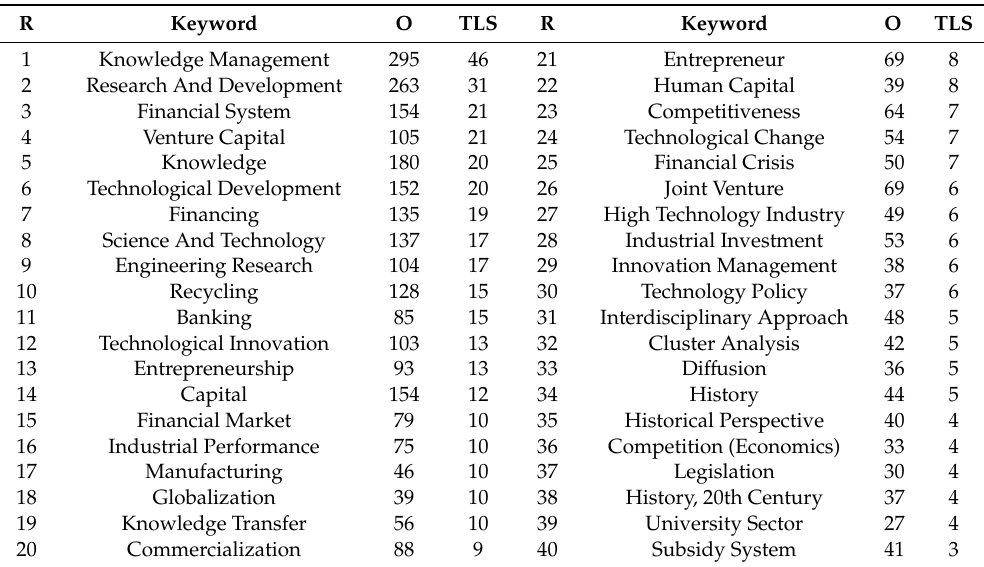
Table 9. Cluster 5. Top 40 keywords (1975–2019).